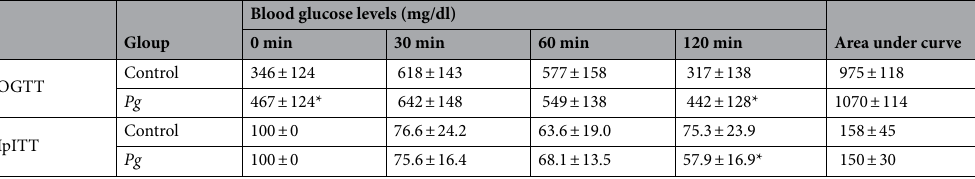
Table 3. Oral glucose tolerance test (OGTT) after 10 h overnight fast, and intraperitoneal insulin tolerance test (ipITT) after 1 h fast. One-way ANOVA with Tukey’s post hoc test was performed for food intake, body weight, blood glucose level, OGTT, and ipITT. Data are expressed as the mean and SEM. n = 8, * P < 0.05 versus CMC control.